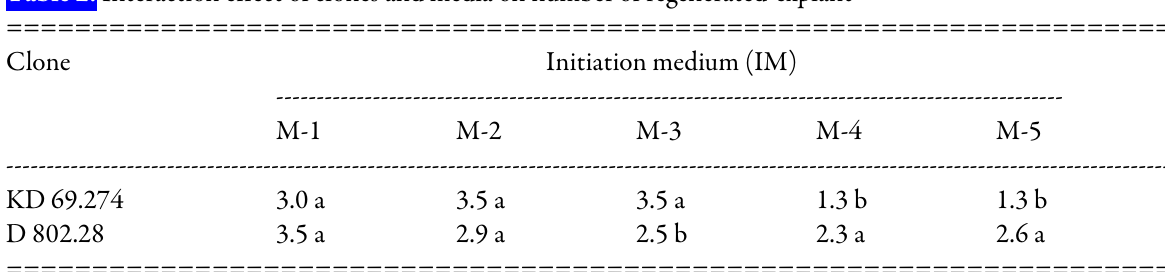
Table 2. Interaction effect of clones and media on number of regenerated-explant